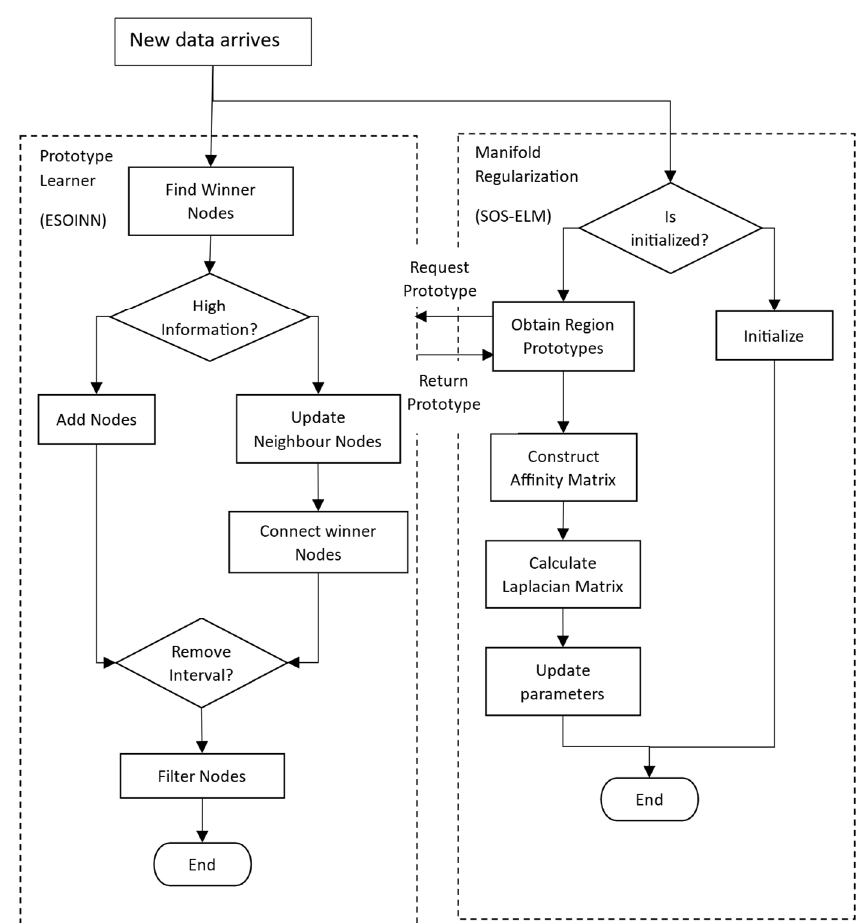
Figure 2. Overview of the proposed approach.